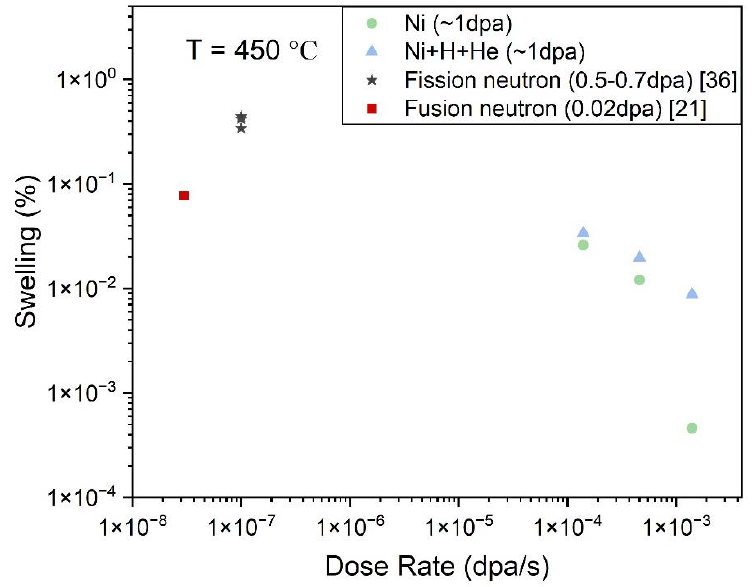
Figure 5. Comparison of data from this work with data of pure nickel irradiated by fusion neutron (from ref. [21]) and fission neutron (from ref. [36]). The irradiation temperatures were all 450 °C.